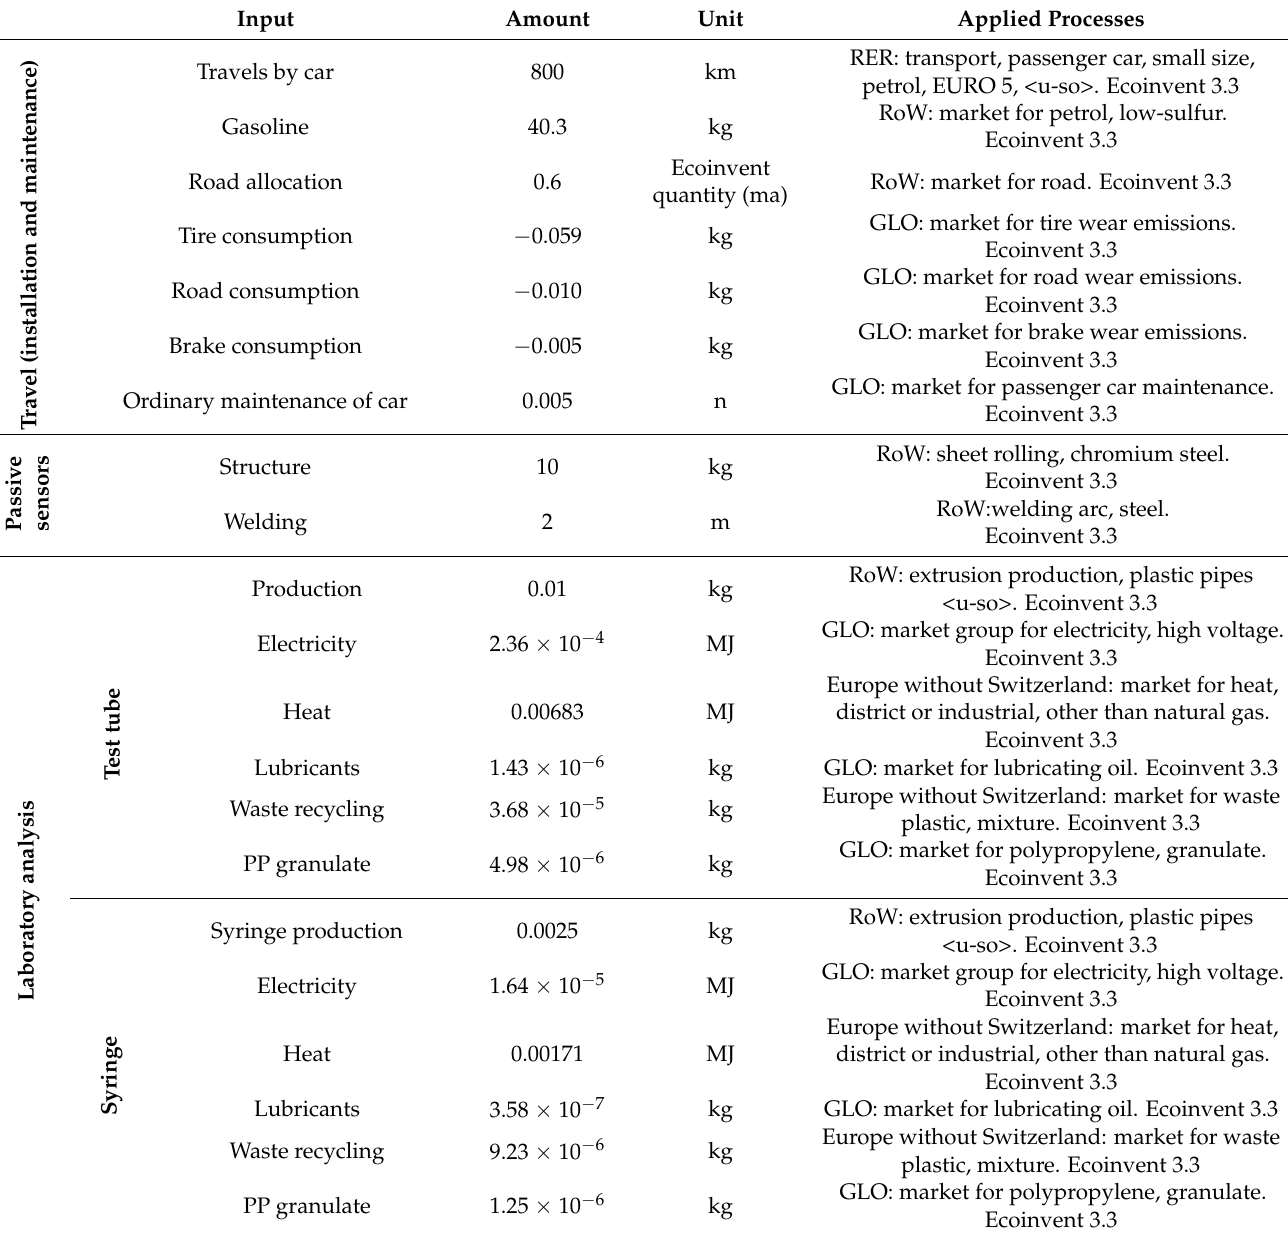
Table 2. Summarized inventory of inputs and outputs referred to the case study of ozone monitoring with passive sensors. The initial acronyms in “applied processes” refer to geographic location: “RER” = Europe; “GLO” = global; “Row” = rest of the